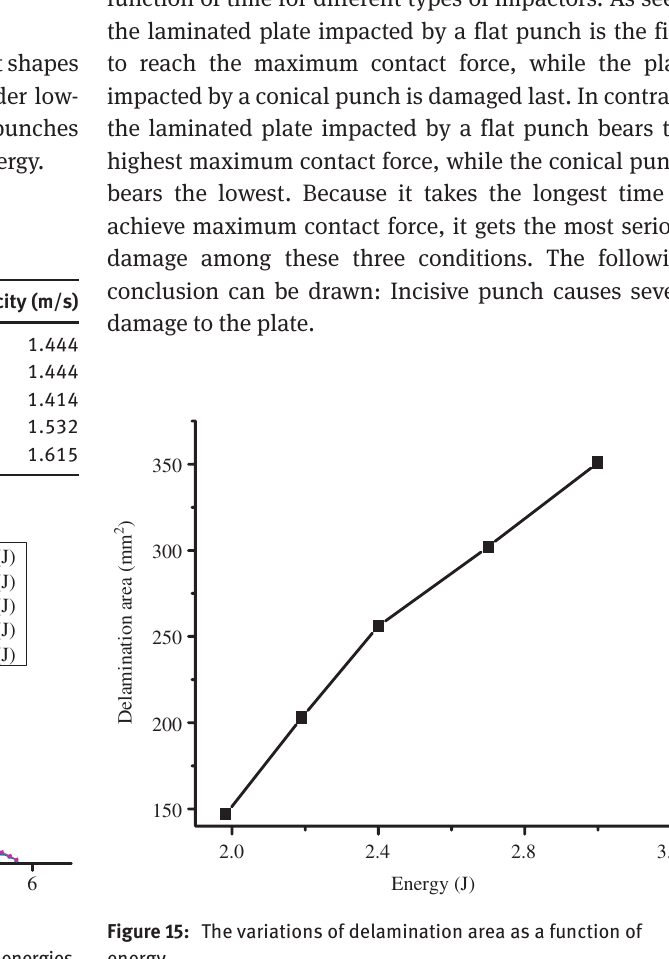
Figure 14: Time curves of contact force under different impact energies.